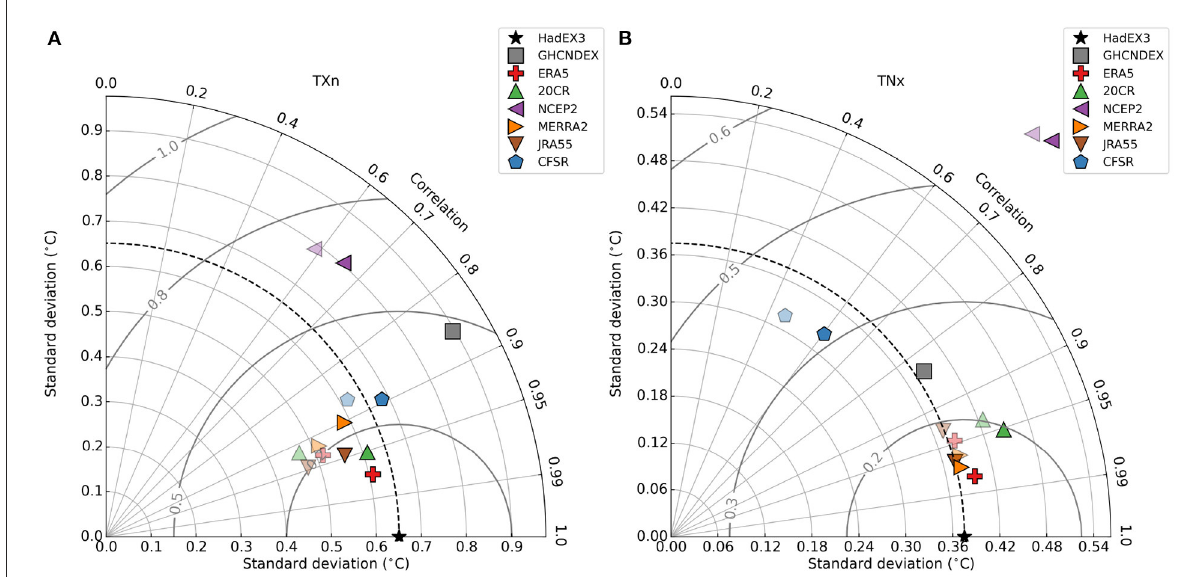
FIGURE3 Taylor diagram for (A) TXn and (B) TNx. The x and y axes on this polar plot show the standard deviation of the time series for each dataset, with the polar axis showing the correlation with the reference dataset, HadEX3. The semi-circles centered on HadEX3 show values of the root-mean-square difference. The fainter symbols are for reanalyses using complete global land coverage, the darker ones are matched to the spatio-temporal coverage of HadEX3. These use the anomaly time series shown in Figures